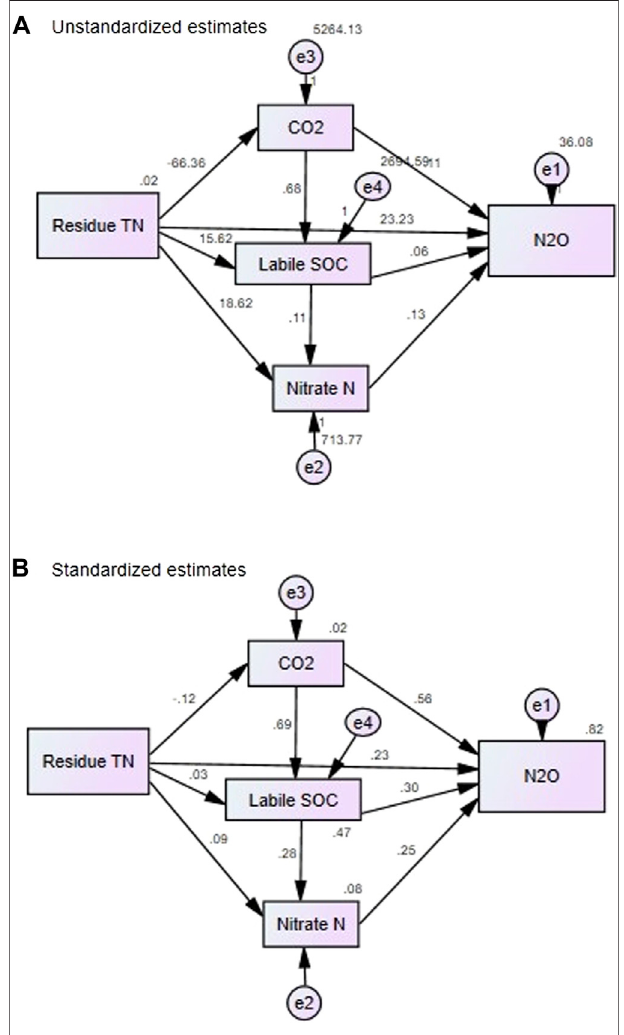
FIGURE6| Structuralequationmodel(SEM)ofsoilN 2 Oemissionbased on residue and soil properties. The numbers next to lines represent (A) unstandardized path coef fi cients and (B) standardized path coef fi cients. R 2 values above each rectangular box in (B) represent the proportion of the variance explaining endogenous variables. The standardized regression weights represent the amount of change in the dependent variable that is attributable to a single standard deviation unit ’ s worth of change in the predictor variable. The unstandardized path coef fi cients (A) represent the amount of change in the dependent variable given a single raw score unit change in the predictor variable. Goodness-of- fi t statistics are shown underneath the modeling